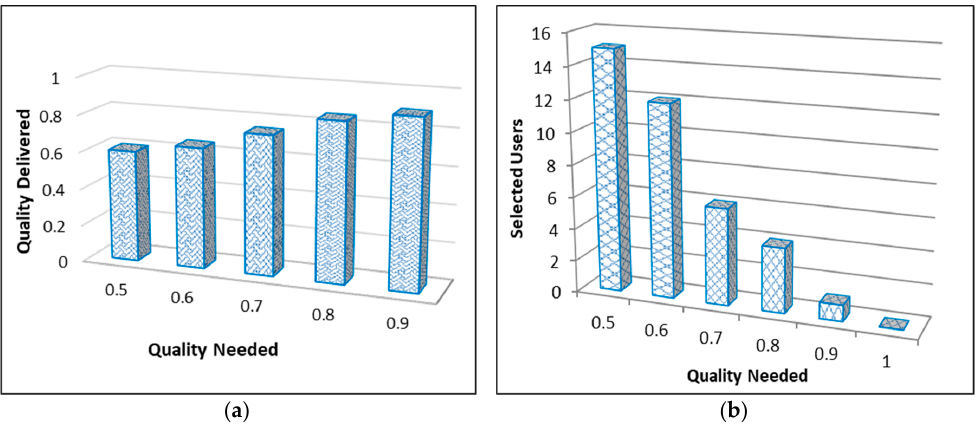
Figure 8. Quality needed is presented for ( a ) delivered quality and ( b ) number of selected